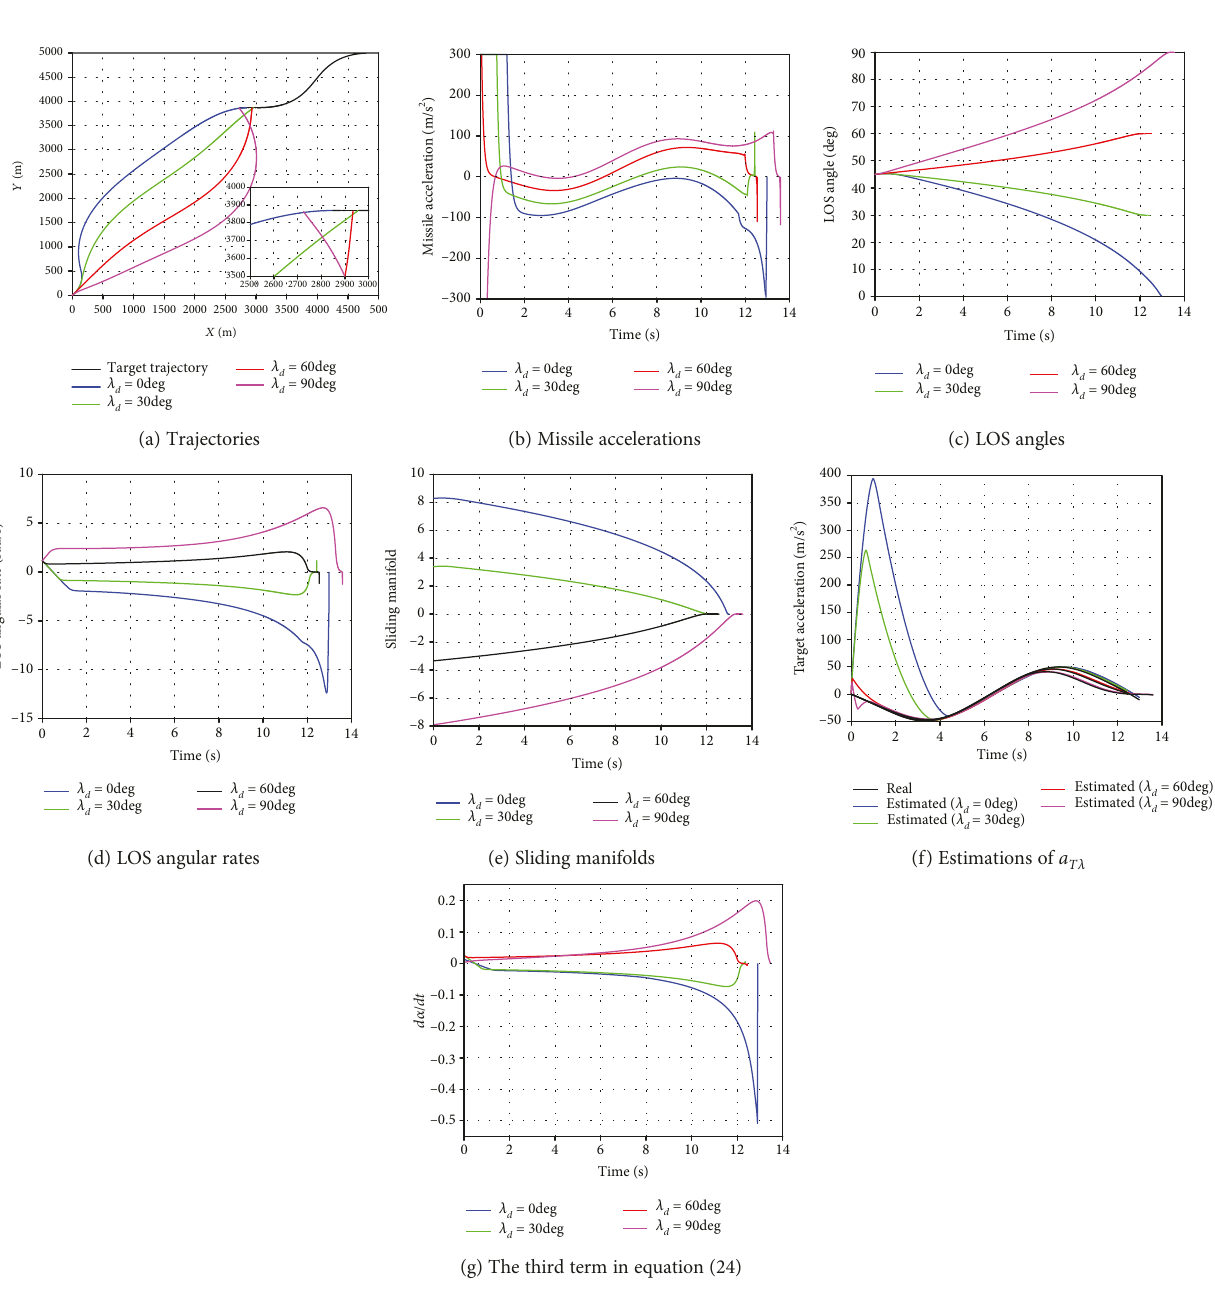
Figure 4: Simulation results of case